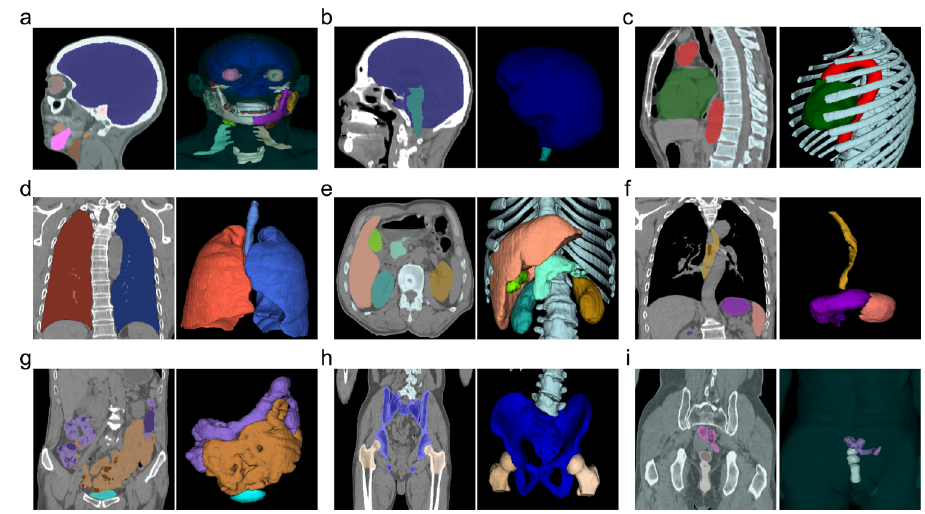
Fig.6|Multipleorgans-at-risk(OARs)segmentationresultsusingtheproposed RTP-Net. a Brain, temporal lobe, eyes, teeth, parotid, mandible bone, larynx, bra- chialplexus;( b )brain,brainstem;( c )heart,trachea,rib,vertebra;( d )lungs;( e )liver, kidney, pancreas, gallbladder; ( f ) stomach, esophagus, spleen; ( g ) large bowel,